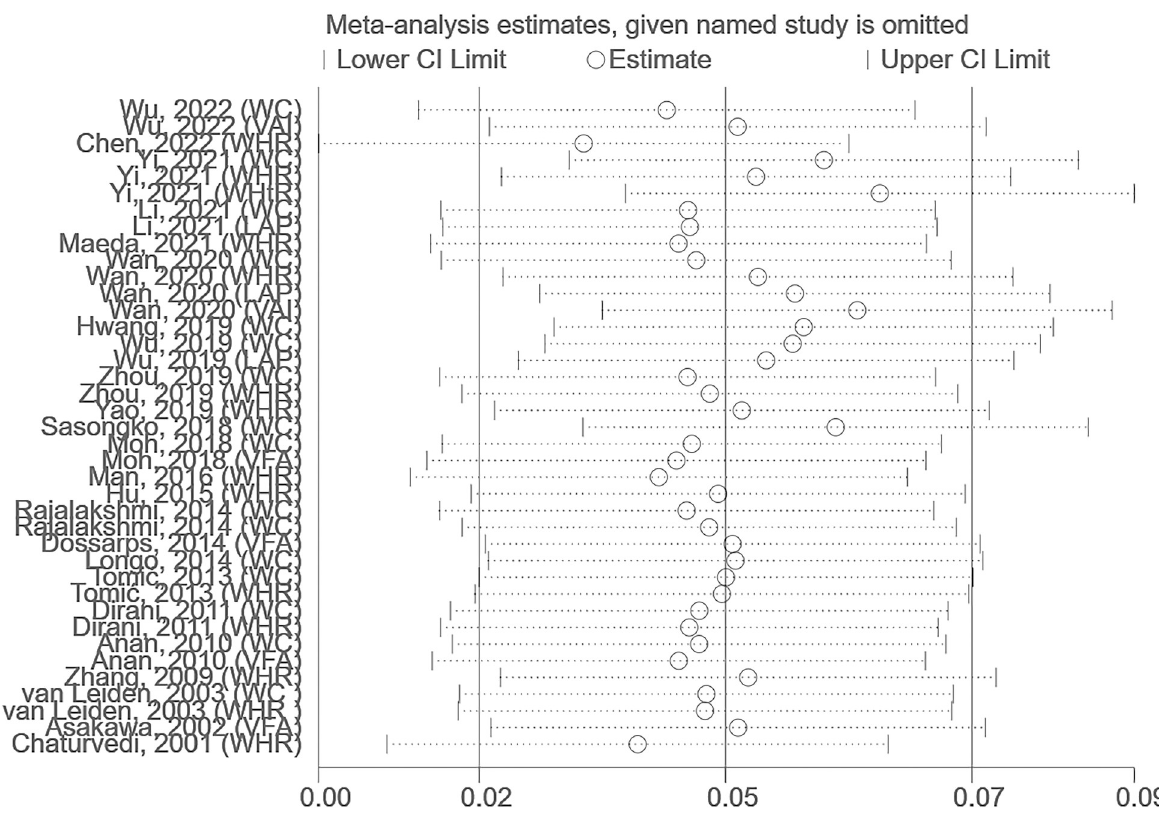
Fig 3. Sensitivity analysis of included 24 studies. Abbreviations: CI, confidence intervals.